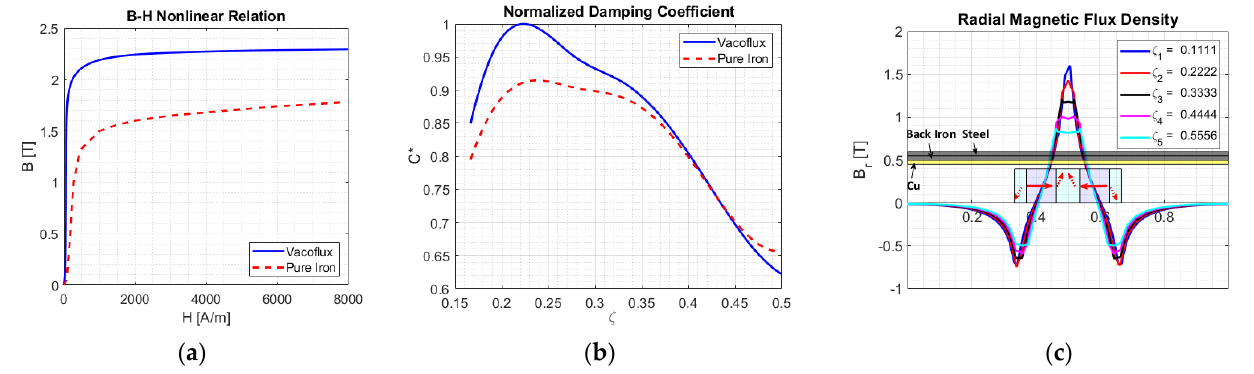
Figure 9. The IP material and thickness effects on damping: ( a ) initial magnetization curves of the investigated soft magnetic materials; ( b ) the normalized damping coefficient of the two investigated materials vs. ζ -the IP height-to-pole pitch ratio; ( c ) radial magnetic flux density on the surface of the conductor along its length vs. ζ -the IP height-to-pole pitch ratio, with a pure iron magnetization curve.